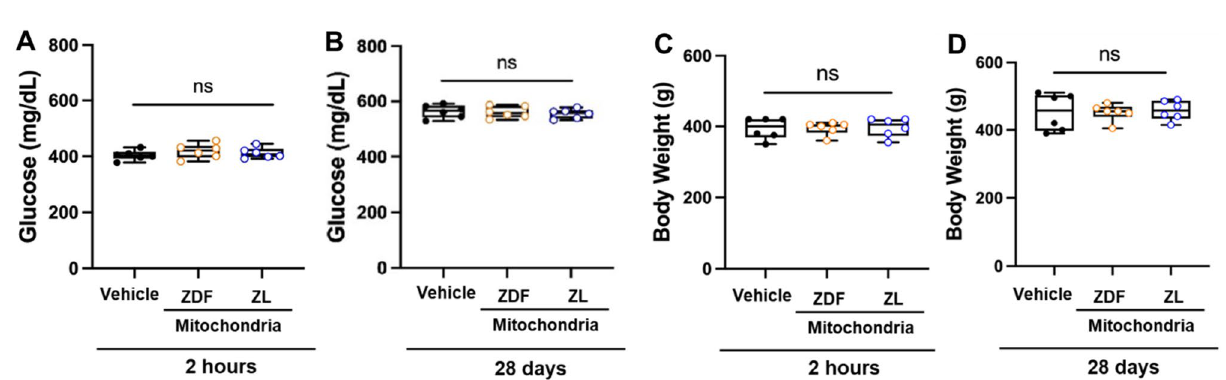
Figure 2. ZDF rat diabetic phenotype. Blood glucose levels (mg/dL) ( A , B ) and body weight (g) ( C , D ) for ZDF rats receiving vehicle alone (Vehicle), or diabetic ZDF- or non-diabetic ZL-mitochondria at 2 h ( A , C ) and at 28 days recovery ( B , D ). No significant differences in blood glucose, body weight or heart weight was observed within or between groups at 2 h or at 28 days recovery. Blood glucose and body weight were significantly increased at 28 days as compared to 2 h recovery. These data suggest that the observed effects of Vehicle, diabetic ZDL-and non-diabetic ZL-mitochondria transplantation are glucose